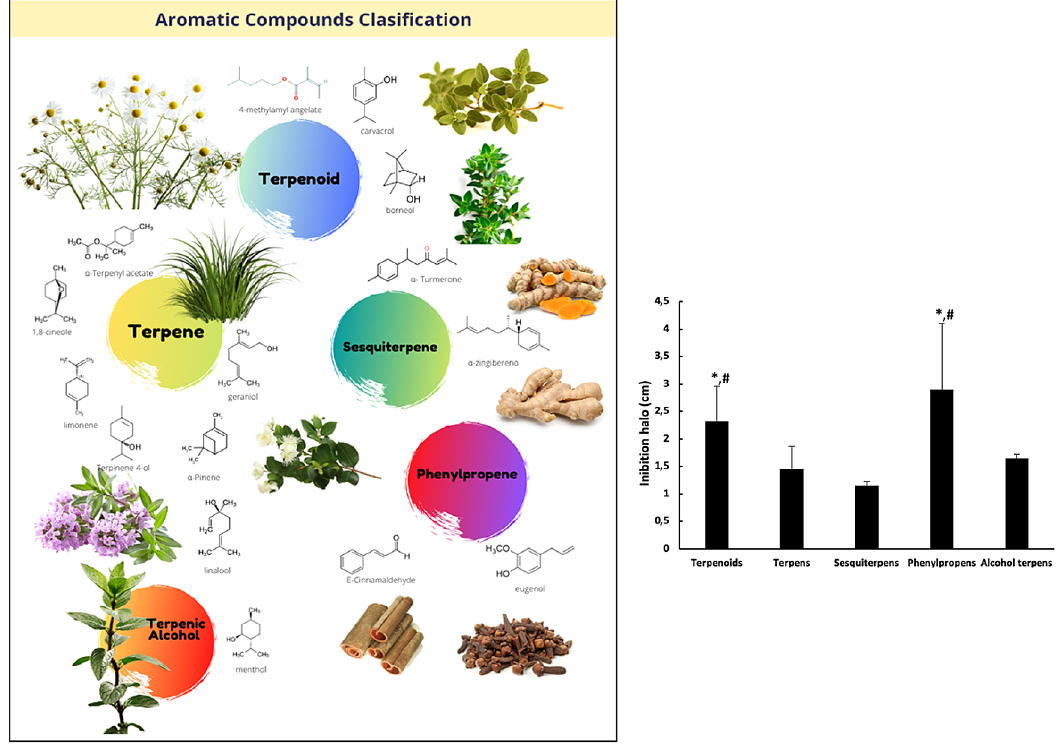
Figure1.Effectofchemicalcomponentsofessentialoilconstituentsonthegrowthof B.subtilis. Intheleftside, the five chemical components groups of the EOs under study. In the right side, the graphical corresponding to the